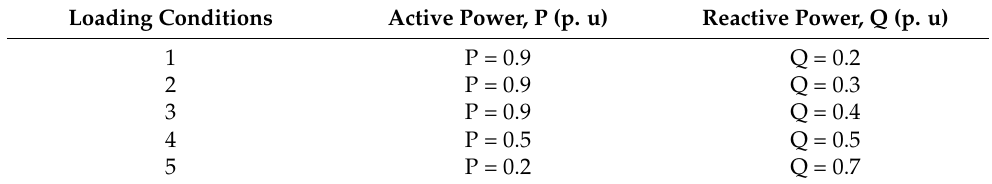
Table 5. Different loading conditions.